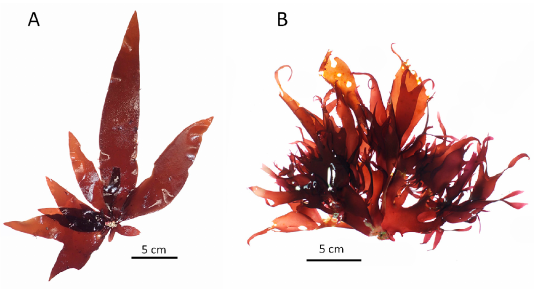
Figure 2. External morphology of two Pachymeniopsis species. ( A ) P. lanceolata , ( B ) P. elliptica .